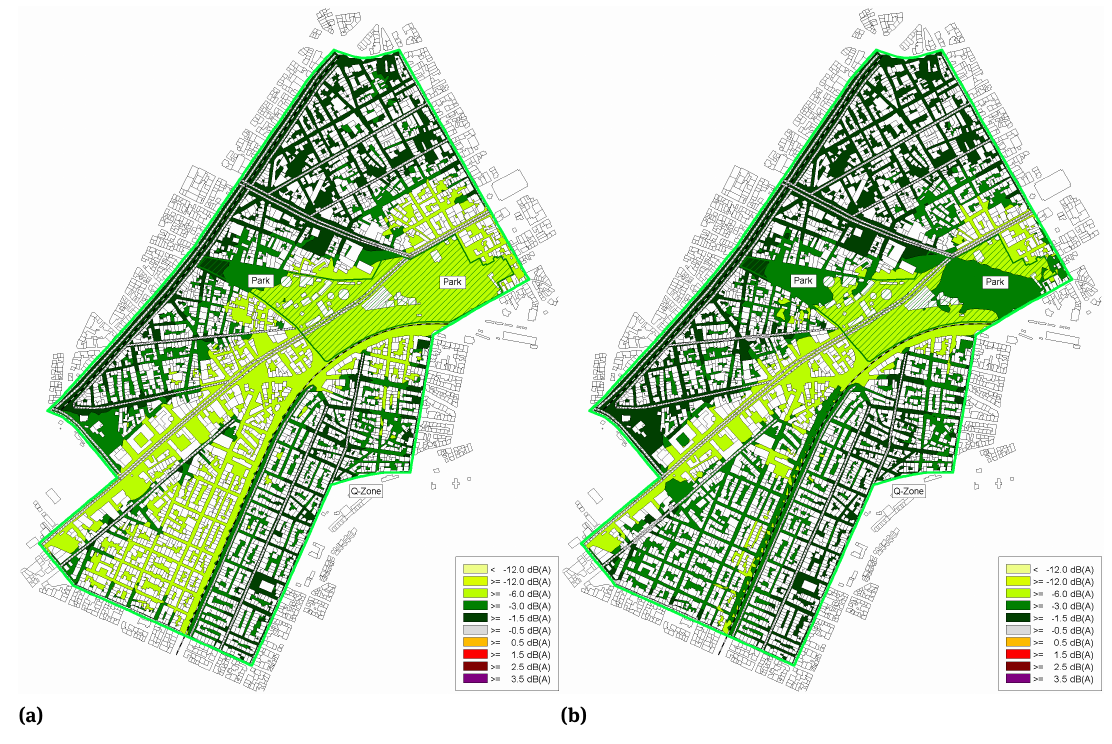
Figure 14: Difference Scenarios (S03-S01 - L